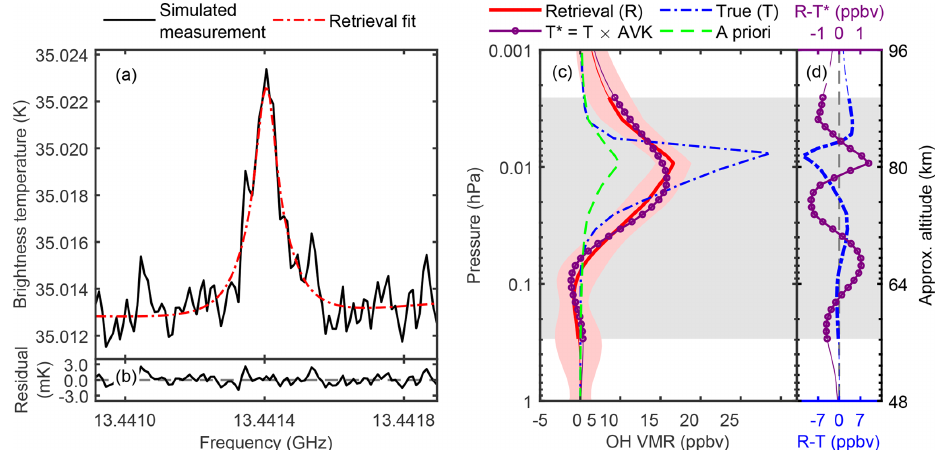
Figure 11. Hydroxyl (OH) retrievals for simulated 6h observations of the OH 13.441GHz emission line using a ground-based radiometer with vertical sensor polarisation at Kilpisjärvi (69 ◦ 03 (cid:48) N, 20 ◦ 48 (cid:48) E), Finland. The forward model clear-sky spectrum is calculated using the model OH profile for substorm conditions in December 2007 with 1mK baseline noise, 10kHz frequency resolution, 82 ◦ zenith angle, and 0 ◦ azimuthal angle (i.e. north-pointing). The simulated OH spectra and retrieval fit are shown in (a) , and the residual differences are shown in (b) . The a priori, true, and retrieved OH volume mixing ratio profiles, and the differences between the retrieved and true profiles, are shown in (c) and (d) . Note that the scales differ for the upper and lower axes of (d) .